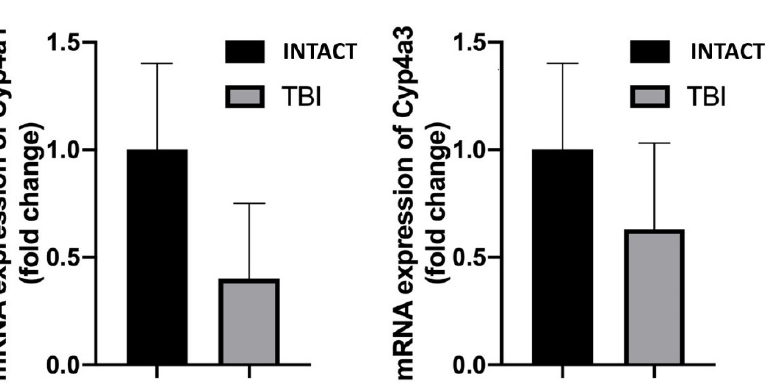
Figure 5. Changes in diameter of isolated middle cerebral arteries (MCAs) in response to 20-hy- droxyeicosatetraenoic acid (20-HETE, 10 − 7 mol/L) metabolite of cytochrome P450 4A enzyme (CYP450 4A) and U46619 (10 − 7 mol/L and 10 − 6 mol/L a stable agonist of TP receptors, intact and after traumatic brain injury (TBI). Data are mean ± SEM. Asterisks indicate significant